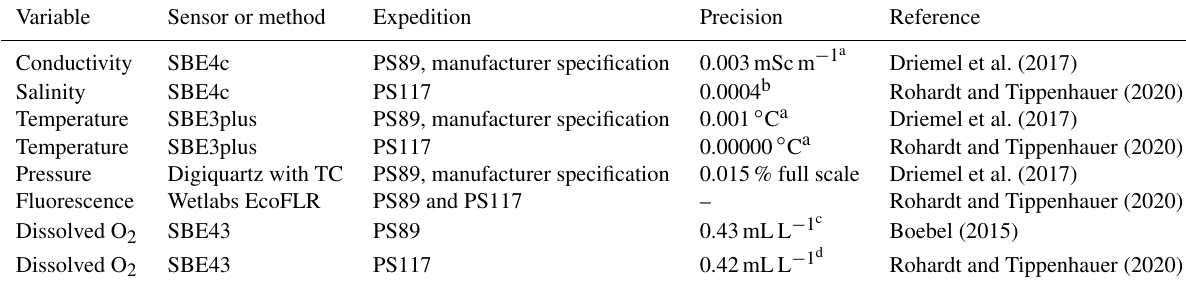
Table C1. CTD sensor precision.